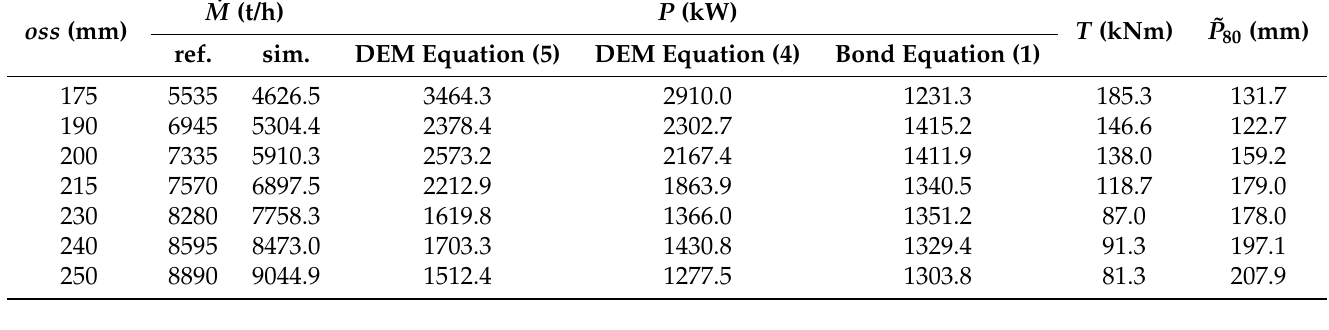
Table 6. Simulation results at different open side settings and ω = 150 rpm and crushing power calculated with Bond’s equation. The throughput of the manufacturer (ref.) and the simulated ones with DEM (sim.) are presented. The power calculated by DEM with all the forces (5) and only radial forces (4) calculated by Bond’s equation are tabulated.